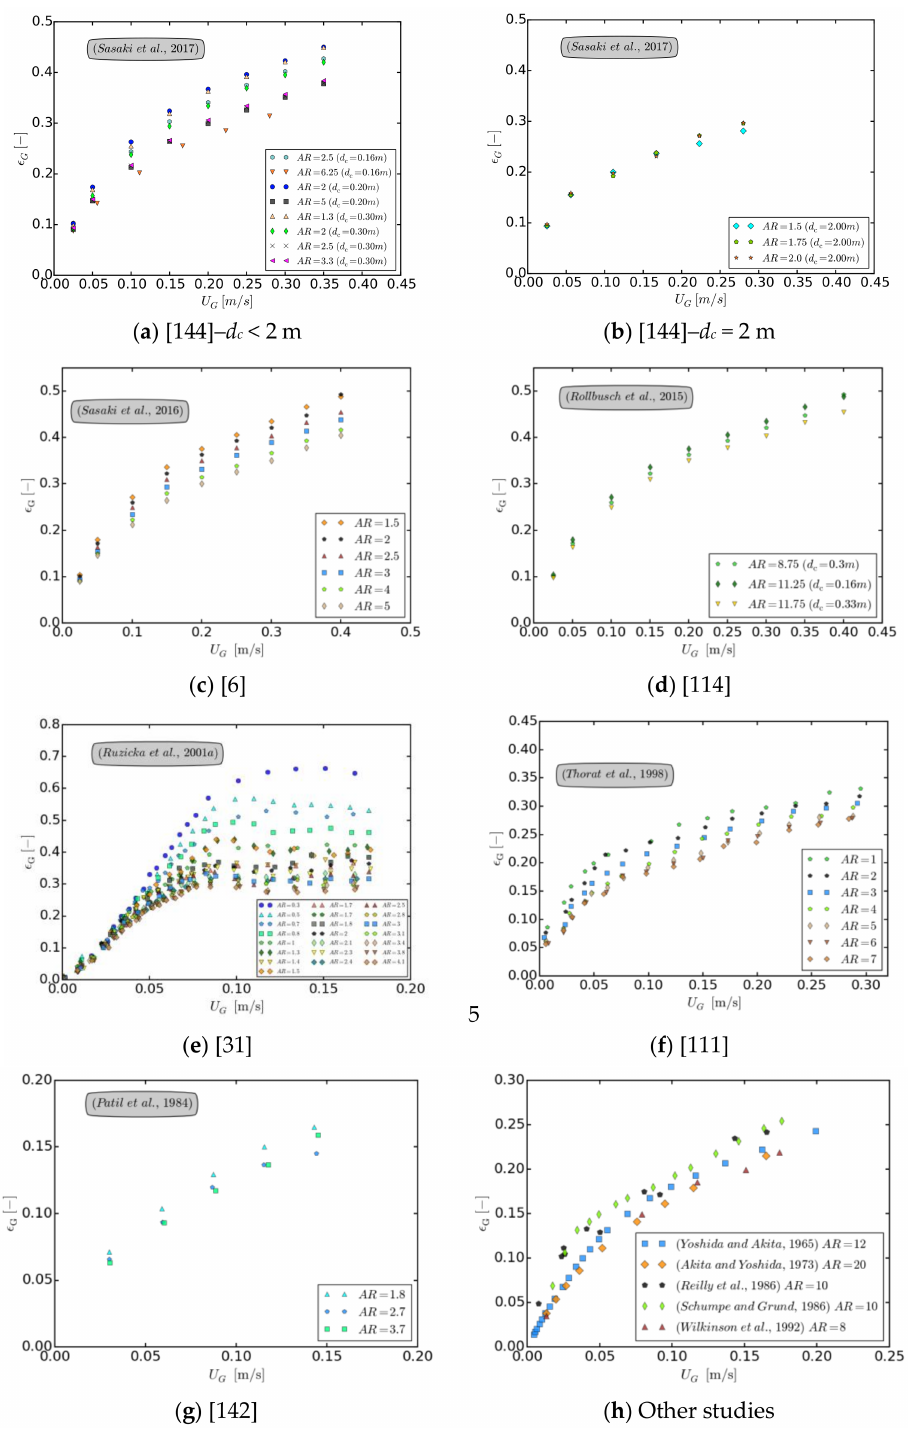
Figure 20. Influence of the aspect ratio in large diameter bubble columns—studies from the